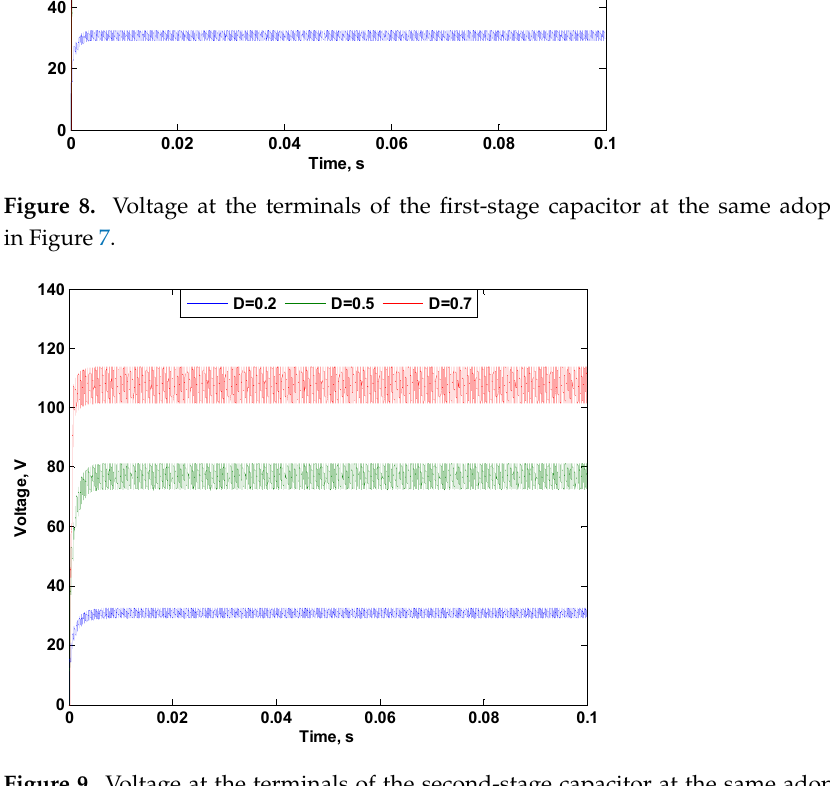
Figure 9. Voltage at the terminals of the second-stage capacitor at the same adopted duty ratios in Figure 7.